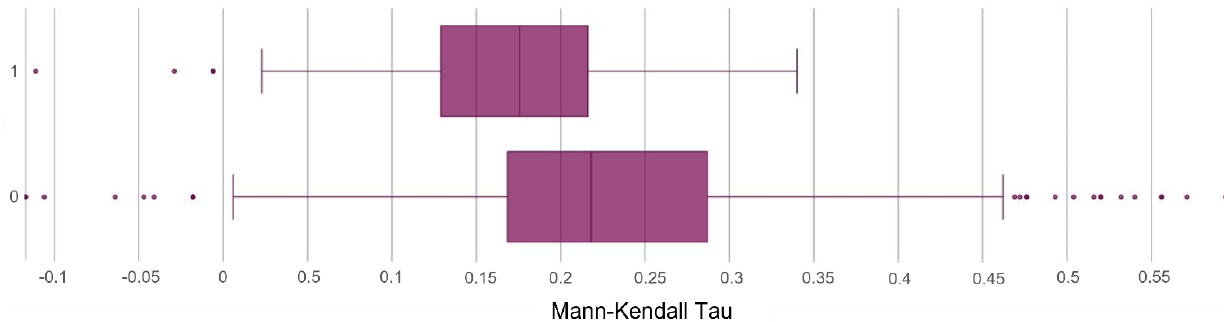
Figure 9 . Increases of nightlight intensity across urban (top) and rural (bottom) areas between 1992 and 2010 using Mann – Kendall tau statistic.